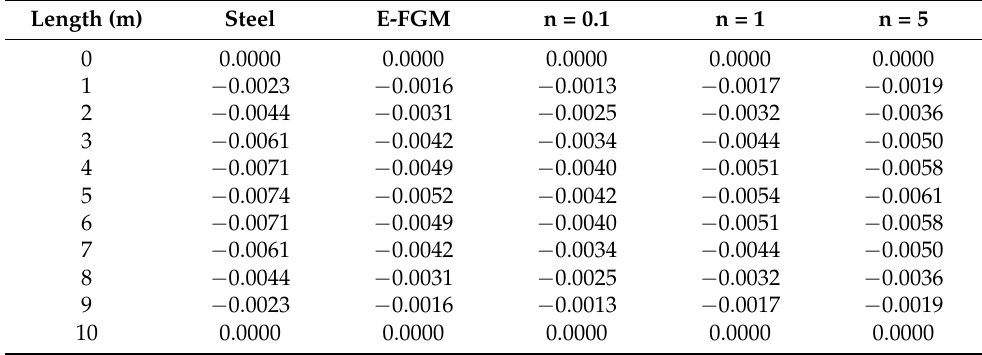
Table 3. Simply supported FGM beam